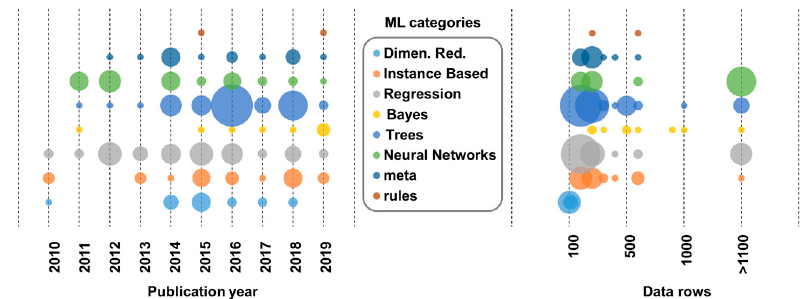
Figure 3. Machine learning categories used over the last decade (left) and their relation with data size samples (right).